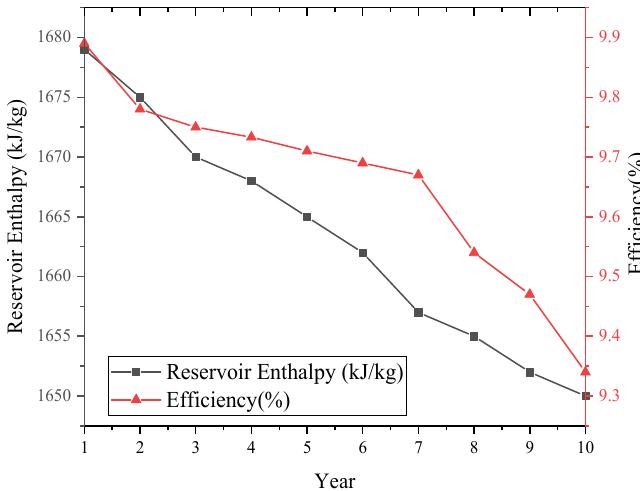
Figure 7. The efficiency and fluid enthalpy change by year.